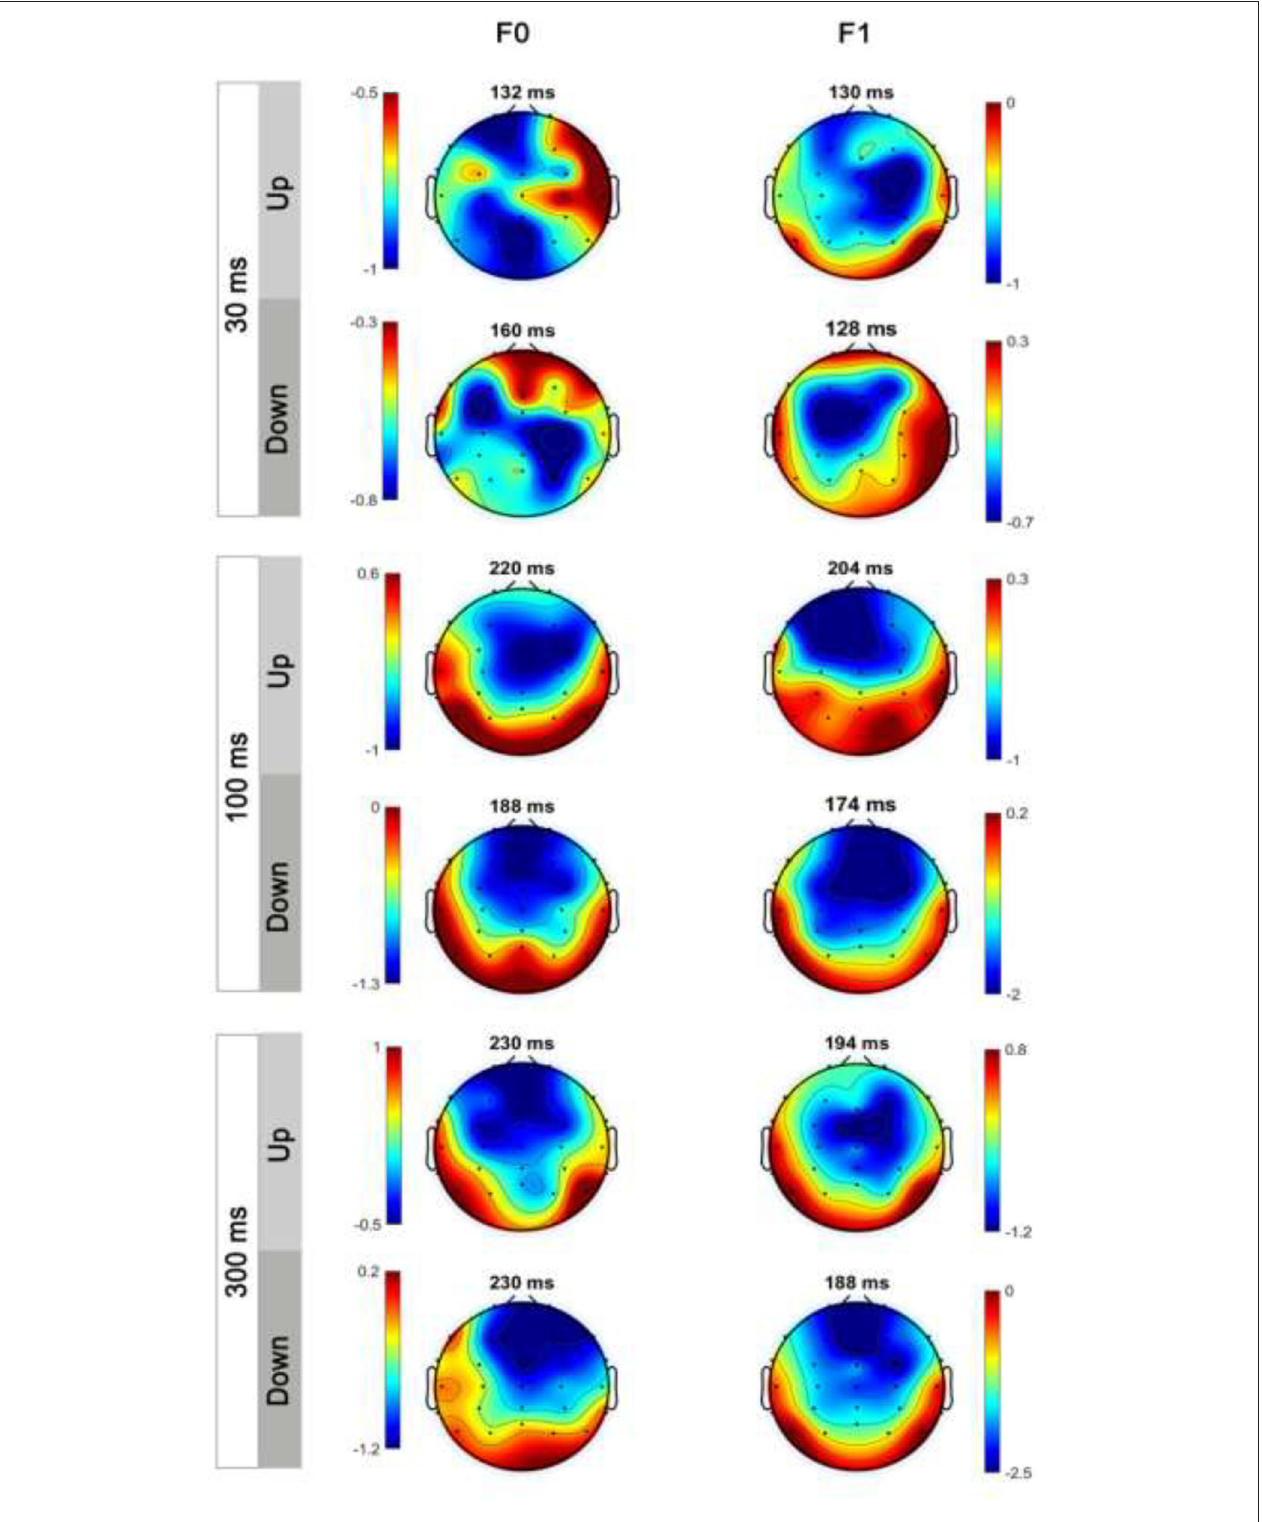
FIGURE 7 | Scale distributions of the electroencephalogram (EEG) topography at MMN mean amplitude for tone sweeps in the F0 and F1 formant frequency for 30ms (top panels), 100ms (middle panels), and 300ms (bottom panels). Color bar is scaled to the MMN mean amplitude in each topography. Negativity is indicated by blue and positivity by red